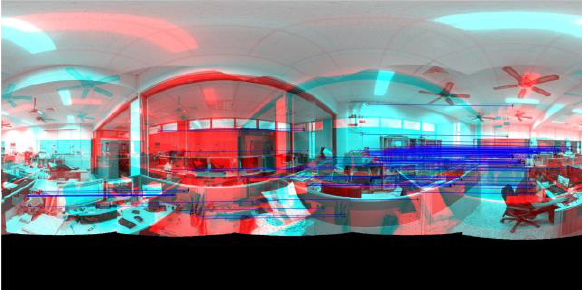
Figure 9(b). Rotation test with affine model